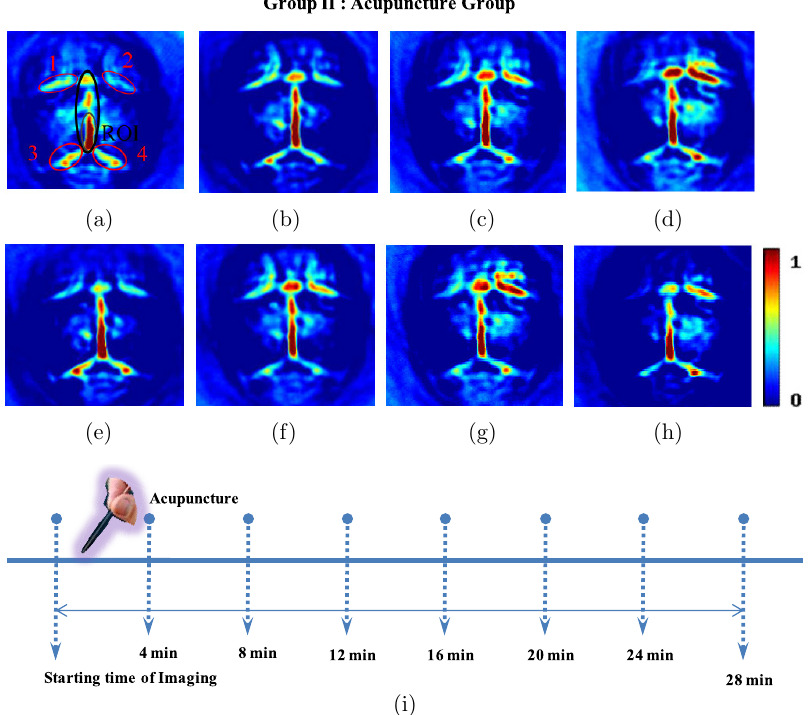
Fig. 4. (a) – (h) Eight in vivo PAT brain reconstructed images of the cerebral vasculature of a mouse brain prior to